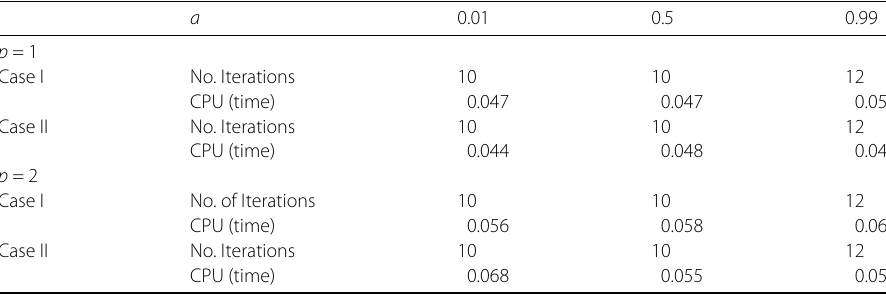
Table 1 Algorithm (VIA) with different group of parameters